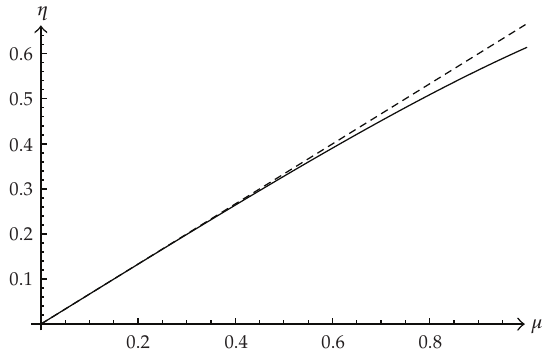
Figure 10: Sheared rod: dimensionless tip deflection as a function of the load. Dotted line refers to the approximate theory | η (cid:3) 0 (cid:4) | (cid:5) 2 μ/